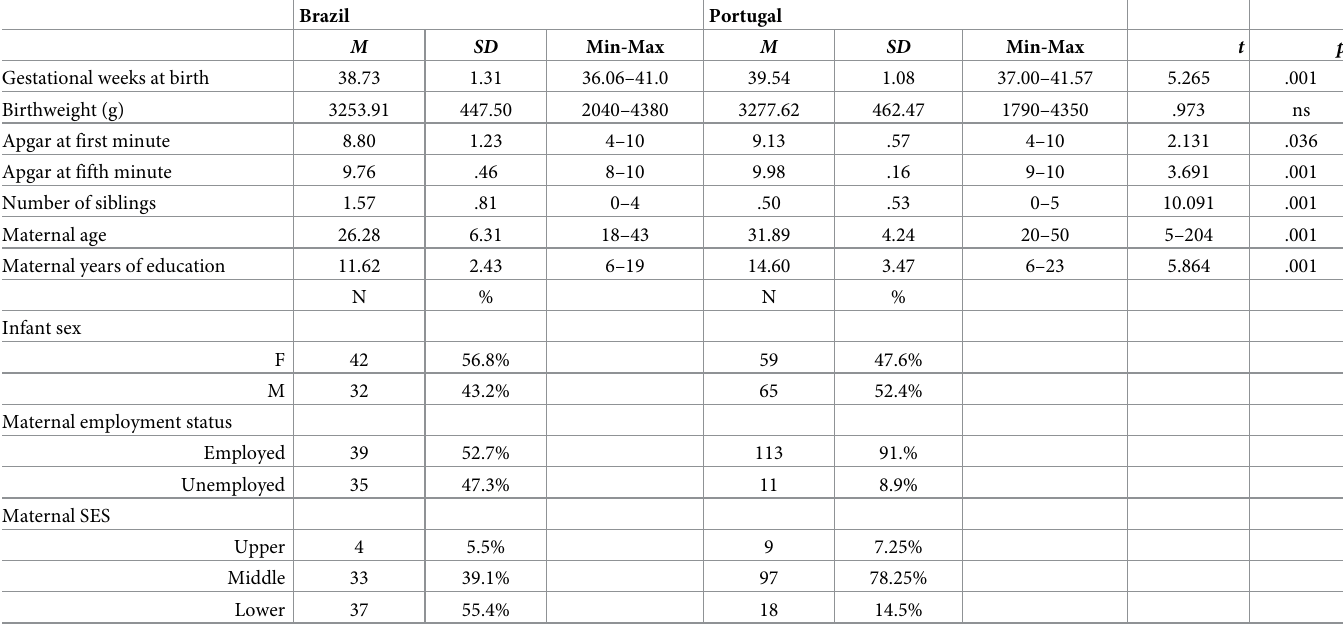
Table 1. Infant and family